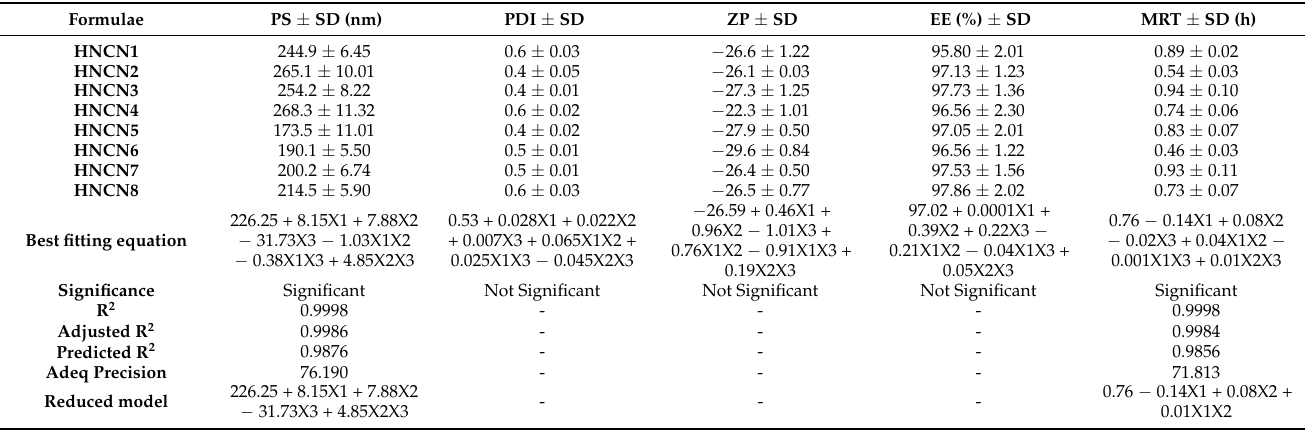
Table 1. Particle size (PS), size distribution (PDI), Zeta potential (ZP), encapsulation efficiency (EE), mean release time (MRT) of the prepared HNCNs and Model summary statistics for the influence of formulations variables on the measured responses *.